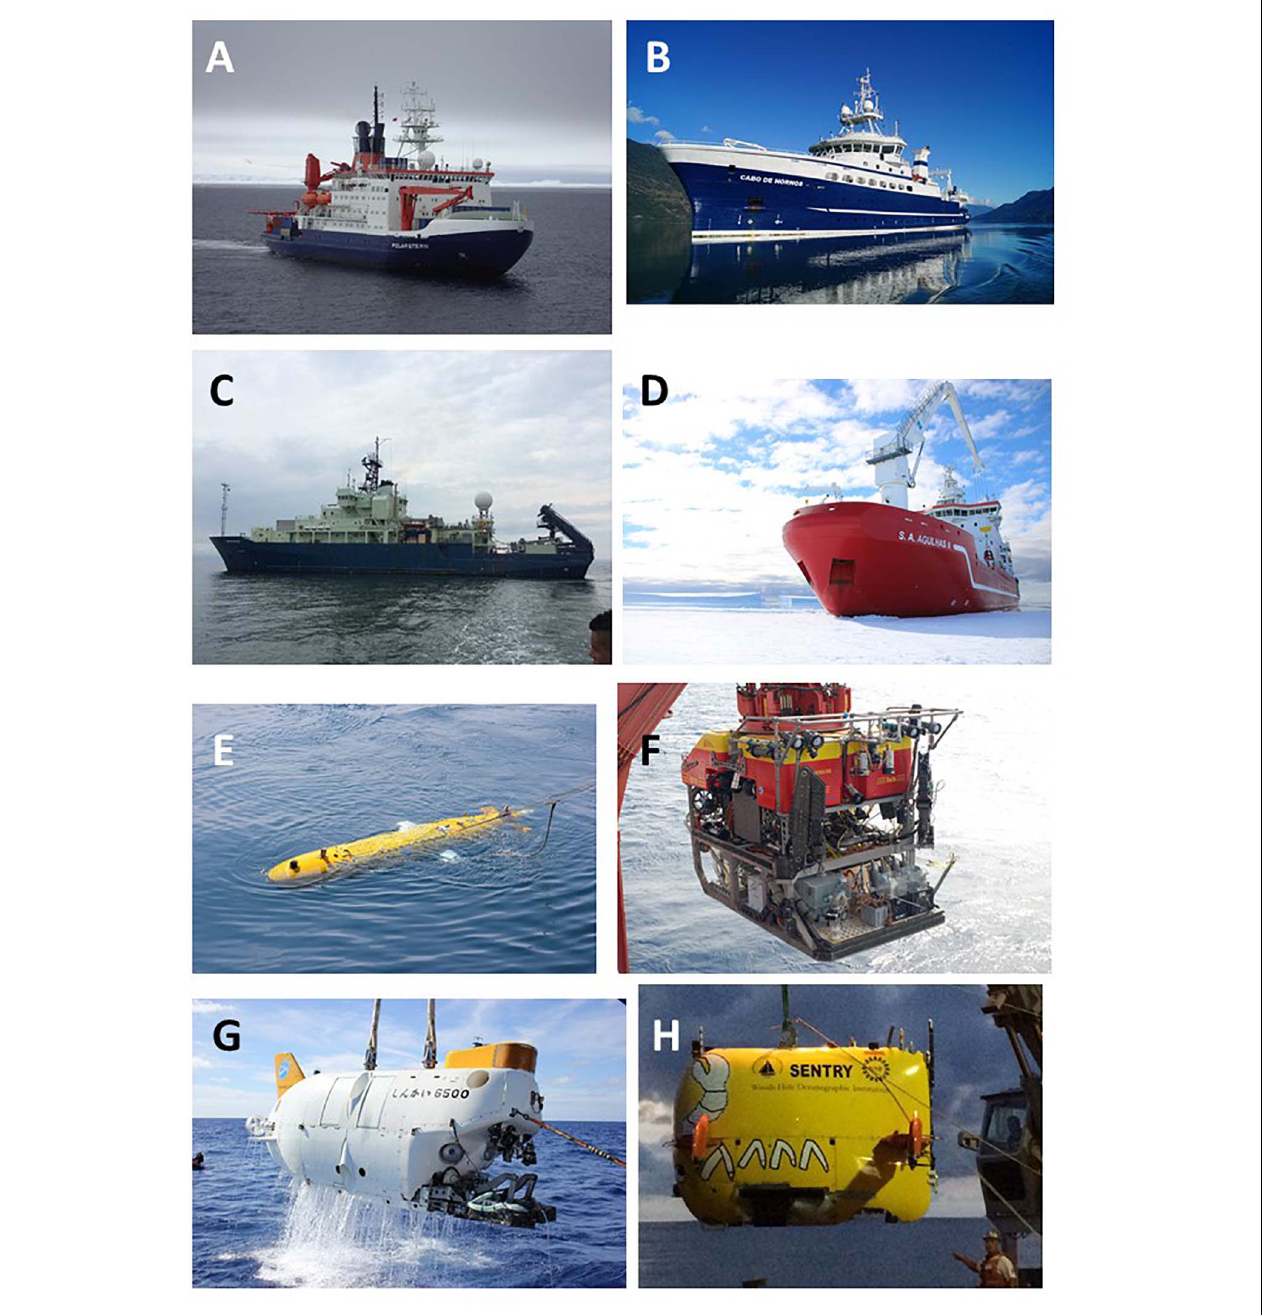
FIGURE 1 | Advanced infrastructure required for marine scientific research in ABNJ. (A) RV Polarstern (Germany; K. Linse), (B) RV Cabo de Hornos (Chile; J. Sellanes), (C) RV Atlantis (United States; T. Shank), (D) SA Agulhas II (South Africa; B. Frinault, University of Oxford), (E) Autosub AUV (United Kingdom; A. D. Rogers), (F) Isis ROV (United Kingdom; A. D. Rogers), (G) Shinkai 6500 submersible (Japan; A. D. Rogers), and (H) Sentry AUV (United States; L. Levin).